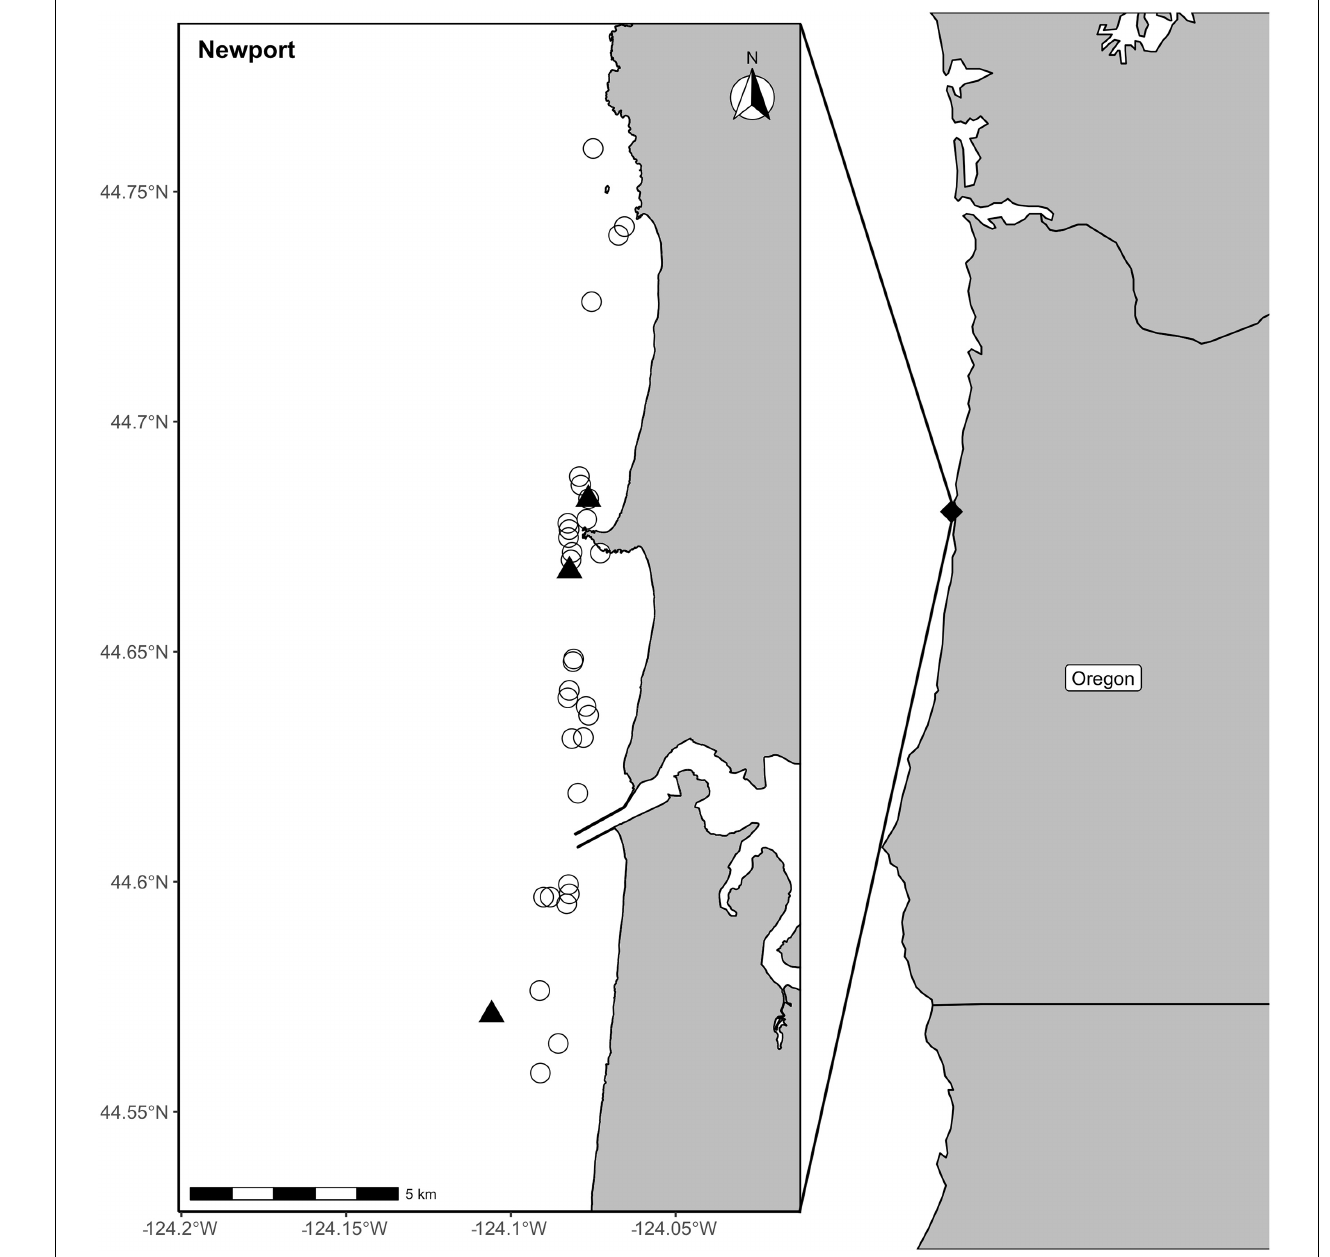
FIGURE 1 | Locations of prey samples collected with a light trap (open circles) or opportunistic collections of surface swarms of crab larvae (black triangles) in Newport, along the Oregon coast in the Pacific Northwest coast of the United